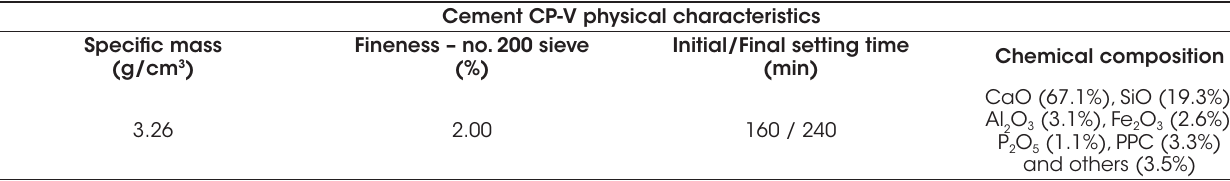
Physical characteristics of the cement